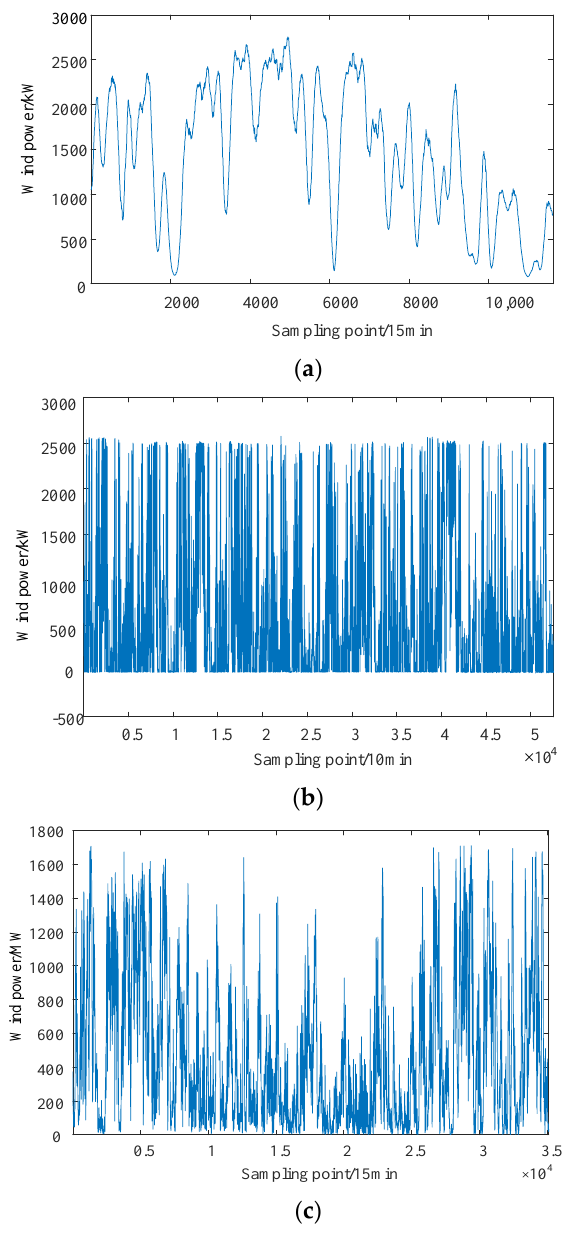
Figure 3. Wind power of different datasets: ( a ) Set 1; ( b ) Set 2; ( c ) Set 3.